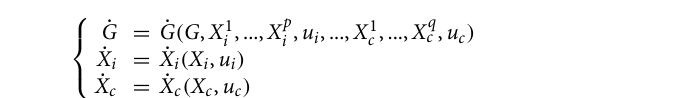
Figure 1. Metamodel of the glucose dynamics subject to insulin injection and physical activity. ( A ) Top: A metamodel based on the Bergman minimal model. The black bold scheme represents the core that is common to three specific models, namely Roy and Parker 8 in blue, Breton 9 in red and Alkhateeb 10 in green. The most exhaustive model in terms of biological processes considers the factthat physical activity increases hepatic glucose production, also causes a depletion of glycogen stocks leading to a decrease in the glycogenolysis rate and finally increasing the glucose uptake of working tissues. Other models synthesize these three mechanisms in one module by considering only the increase in the glucose uptake. The ingested carbohydrates can be easily added to these schemes as a third input channel. ( B ) Bottom: A multicompartment metamodel for the diffusion of carbohydrates, insulin and physical activity and their effects on glycaemia. These multiple compartments act as a ’buffer’ for the diffusion of the primary input. Their behaviours are described in mathematical diffusion equations, which are linear in the case of injected insulin diffusion or in the case of carbohydrates digestion. However, they are nonlinear for some physical activity